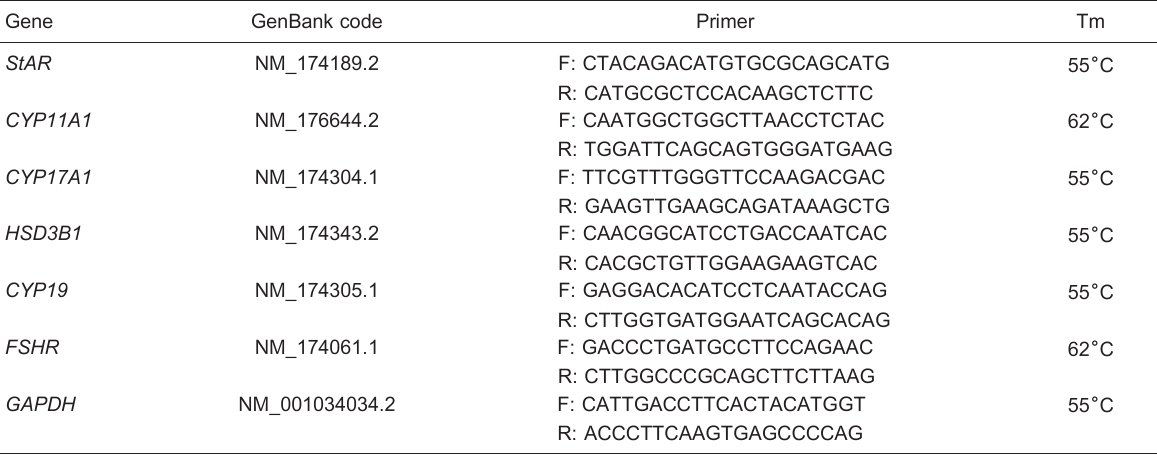
Table 1. Sequences of target bovine gene primers and melting